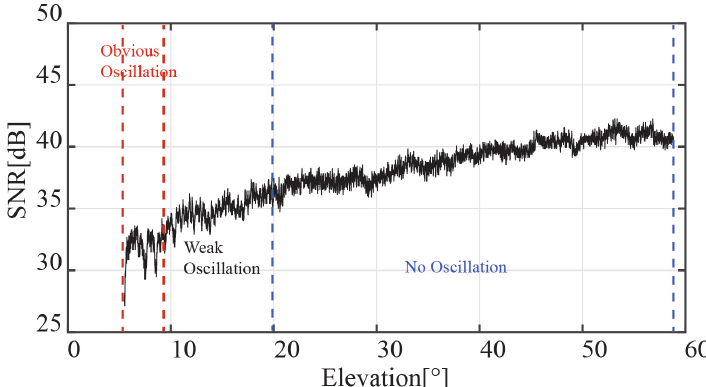
Figure 9. SNR of GPS PRN2 when the corn is higher than the GNSS